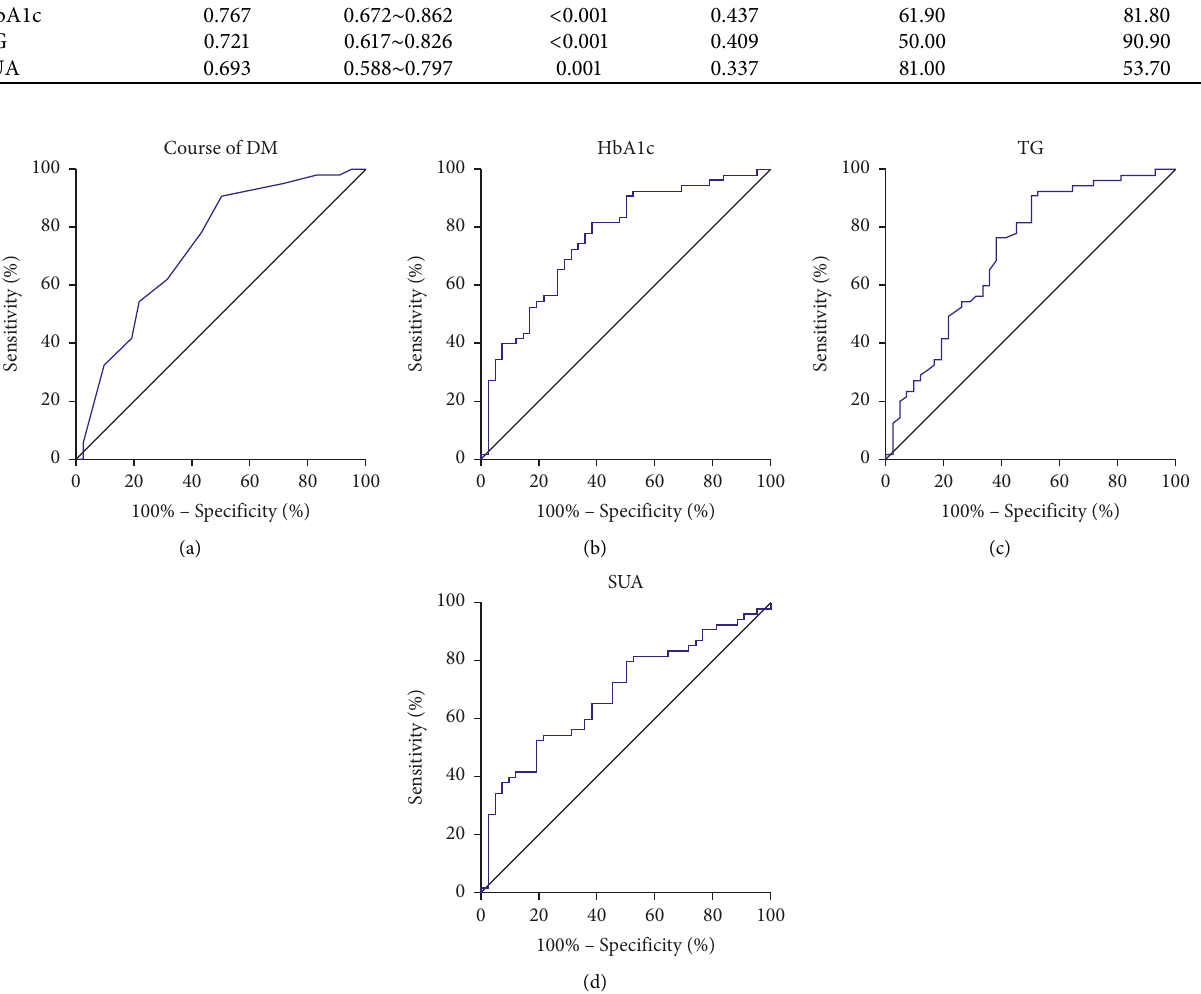
Figure 3: ROC analysis of DR risk factors. (a ∼ c) The predictive value of DM disease duration, HbA1c, TG, and SUA on the occurrence of DR,